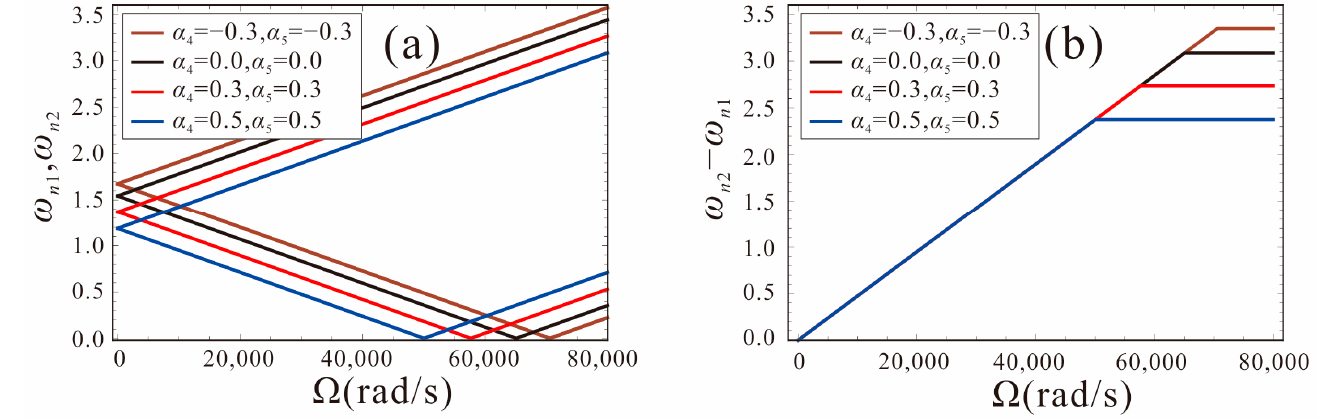
Figure 9. The first order natural frequency versus input angular velocity of the system with different shape factors.